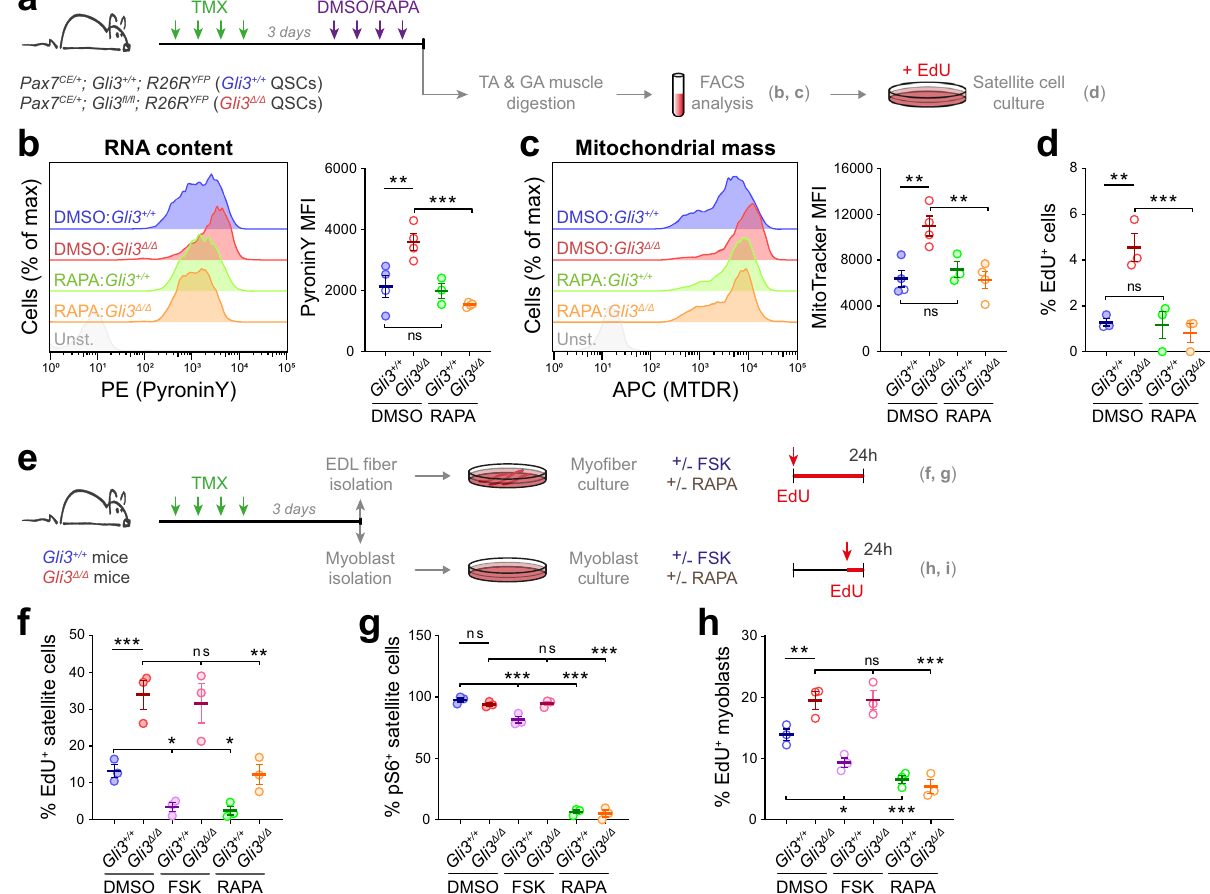
Fig. 7 GLI3R cooperates with mTORC1 signaling to regulate satellite cell function. a Experimental design. Gli3 + / + and Gli3 Δ / Δ mice were treated with Rapamycin (RAPA) and QSCs were analyzed for RNA content and mitochondrial mass by FACS and plated 40 h with EdU to analyze cell cycle entry. b Left, Representative plots of Gli3 + / + and Gli3 Δ / Δ QSCs isolated from DMSO- or RAPA-treated mice and stained for PyroninY (Unst. unstained); Right, MFI of PyroninY staining. c Left, Representative plots of Gli3 + / + and Gli3 Δ / Δ satellite cells isolated from DMSO- or RAPA-treated mice and stained for MitoTracker Deep Red (MTDR). Right, MFI of MTDR staining ( b , c , n = 4 mice for DMSO- Gli3 + / + , DMSO- Gli3 Δ / Δ , RAPA- Gli3 Δ / Δ and n = 3 mice for RAPA- Gli3 + / + ). d Proportion of EdU + satellite cells 40 h post-isolation ( n = 3 mice). e Experimental design. EDL myo fi bers and myoblasts were isolated from Gli3 + / + and Gli3 Δ / Δ mice and cultured in presence of forskolin (FSK) or RAPA for 24 h. Myo fi bers were treated with EdU for 24 h post-isolation. Myoblasts received 1h-EdU pulse post-treatment. f Proportion of EdU + satellite cells ( n = 3 mice). g Proportion of pS6 + satellite cells ( n = 3 mice). h Proportions of EdU + myoblasts in Gli3 + / + and Gli3 Δ / Δ cultures upon FSK and RAPA treatments ( n = 3 biologically independent samples). Empty dots are males and colored dots are females. Means ± SEM; One-way ANOVA test with Fisher ’ s LSD for multiple comparisons for panels b , c , d , f , g , h , * p < 0.05; ** p < 0.01; *** p <